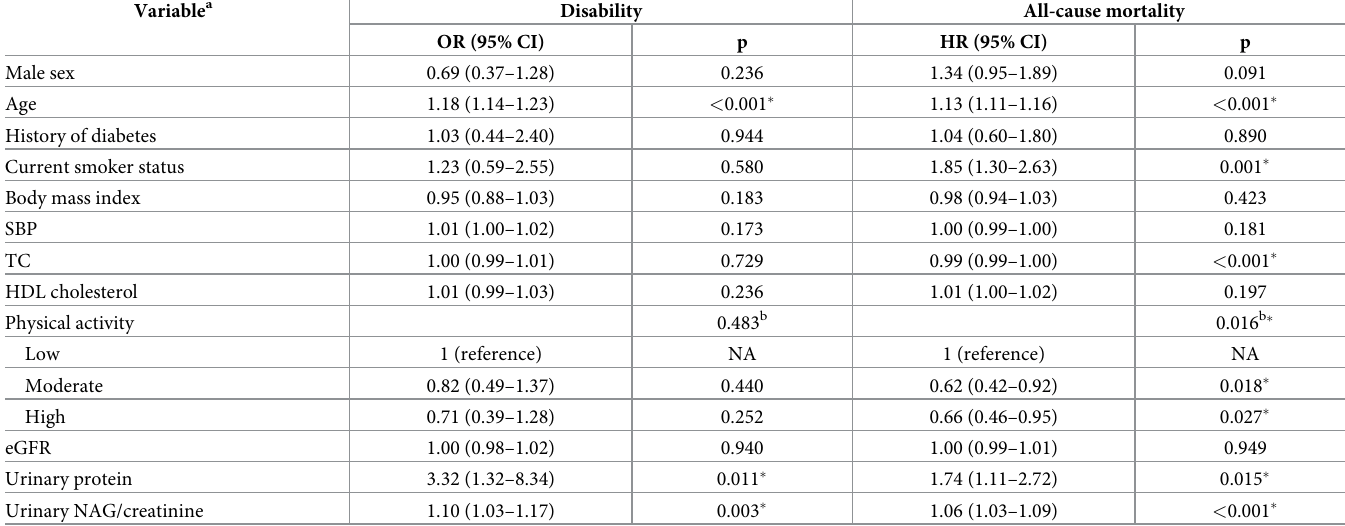
Table 6. Multivariable-adjusted odds ratios (ORs) for disability and hazard ratios (HRs) for all-cause mortality adjusted for cardiovascular risk factors and kidney injury markers. Variable a